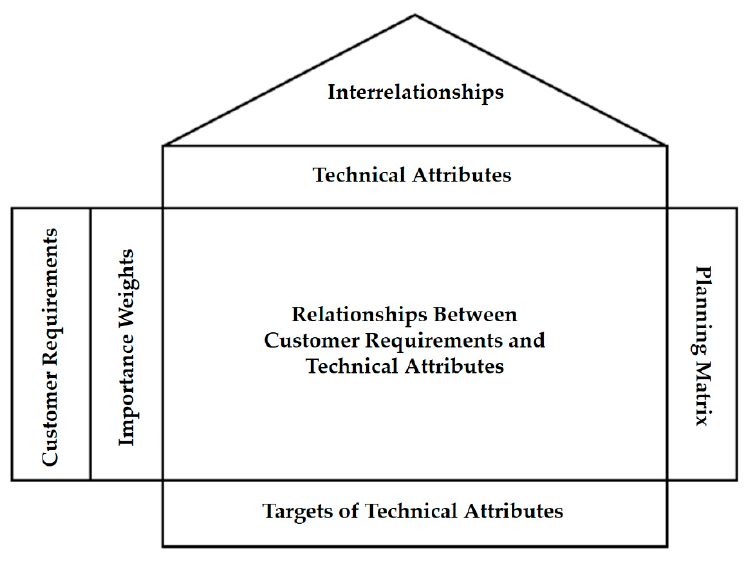
Figure 2. House of quality [10].